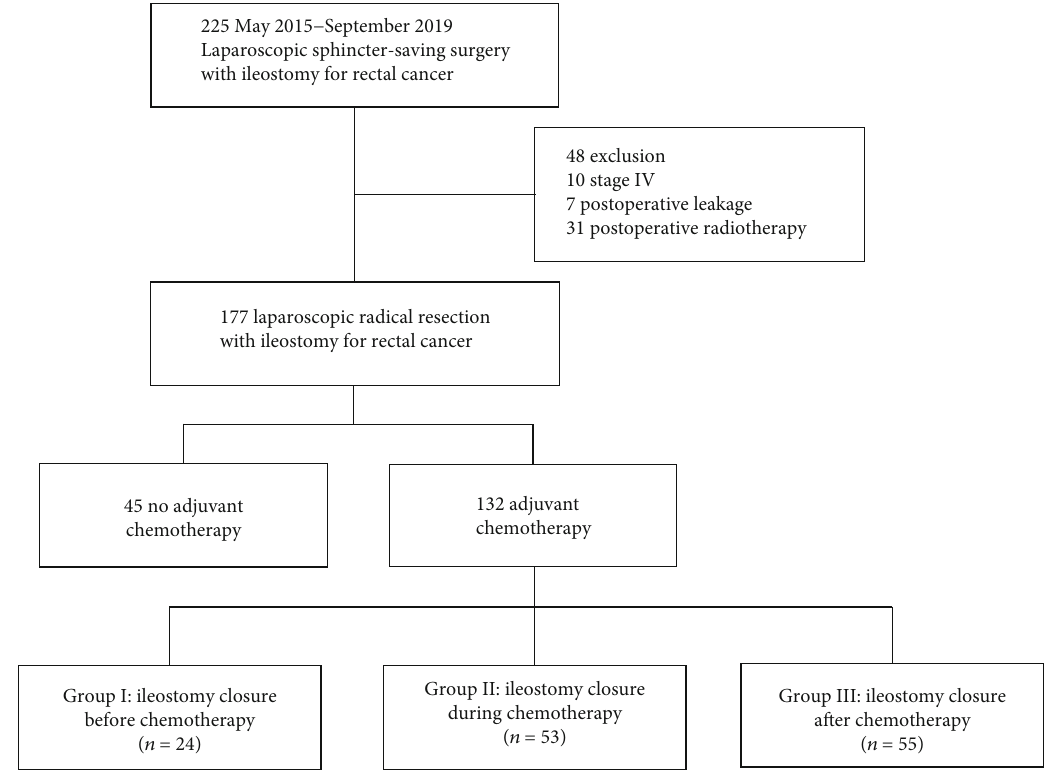
Figure 1: Flowchart of patients included in the